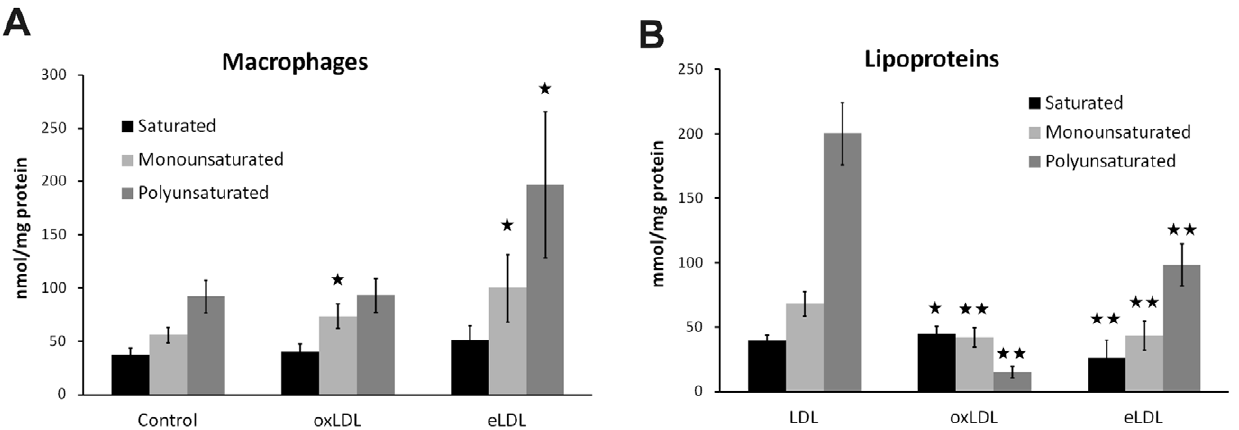
Figure 4. ESI-MS/MS analysis of lipoprotein loaded macrophages and native LDL, oxLDL and eLDL. (A) eLDL induced significant accumulation of mono- and polyunsaturated lipid species in macrophages. oxLDL only elevated levels of monounsaturated species. (B) Lipid compositional analysis of lipoproteins. oxLDL showed substantially decreased levels of mono- and polyunsaturated lipids compared to native LDL. Saturated lipid species were decreased in eLDL, but increased in oxLDL. Mean and standard deviation of six (A) or eleven (B) replicates from different donors. Mann-Whitney U test: *p , 0.05, **p , 0.01.